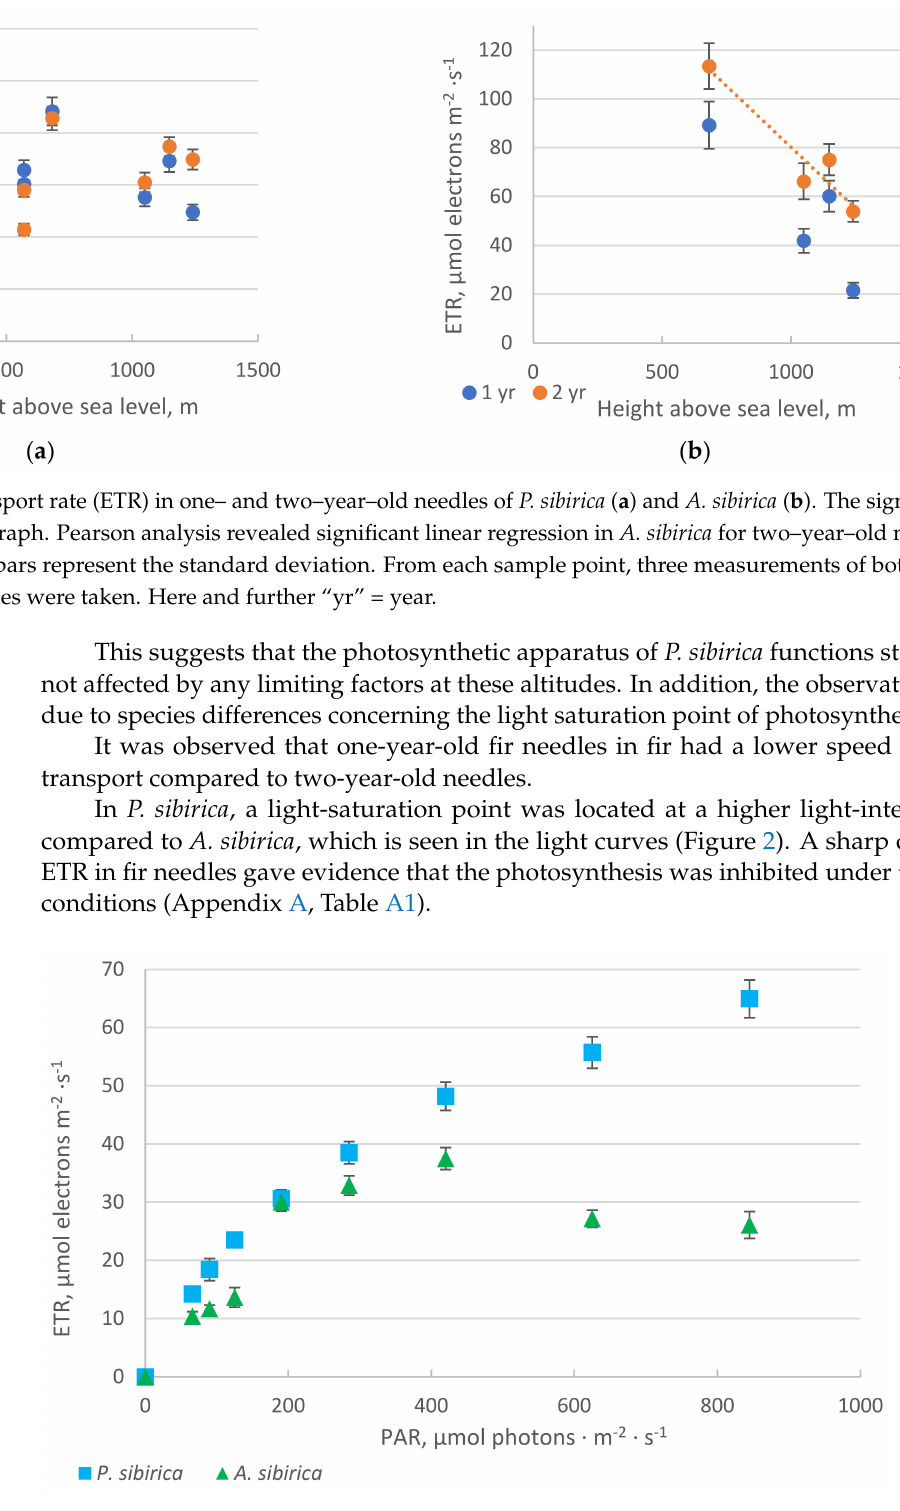
Figure 2. Change of ETR in needles of A. sibirica and P. sibirica against PAR. The vertical bars represent the standard deviation. For each PAR level, three measurements for two–year old needles were done. PAR = photosynthetic active